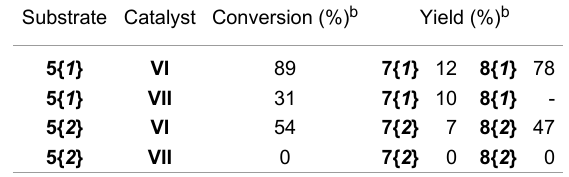
Table 2: Intramolecular alkyne hydroarylation under acidic conditions.